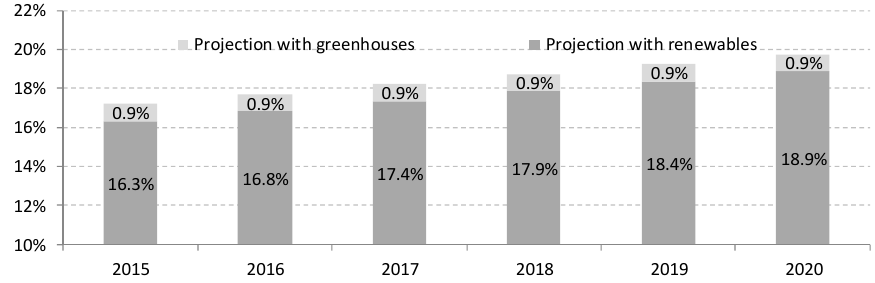
Figure 6. Projection renewables contribution with greenhouses (Authors’ calculation).